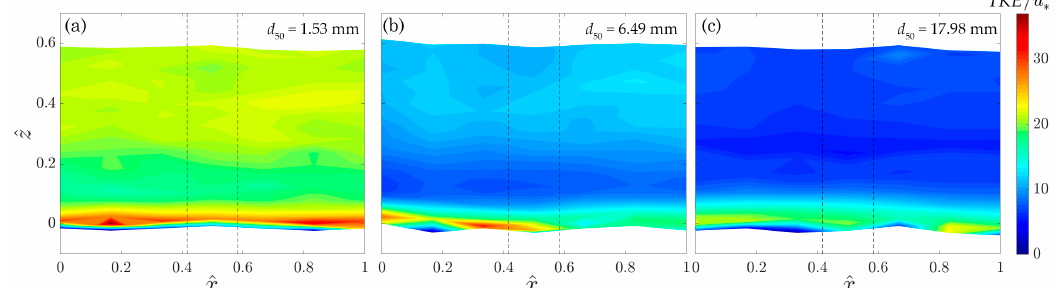
Figure 18. Contours of the dimensionless TKE on the vertical central plane (from D to U) for ( a ) Run 1, ( b ) Run 2, and ( c ) Run 3. The black broken lines indicate the cylinder